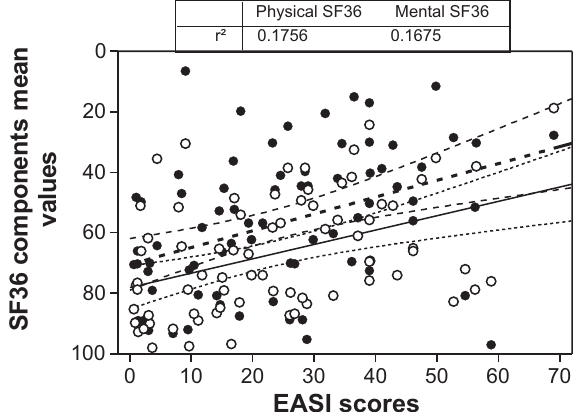
Figure 2 - Distribution and correlation with 95% intervals of mean values of physical (closed circles and dashed line) and mental (open circles and solid line) components of the SF-36 generic QoL test in AD adults Brazilian patients as related to disease severity, expressed by EASI scores. Table shows values of r 2 , all data significant (p<0.001)